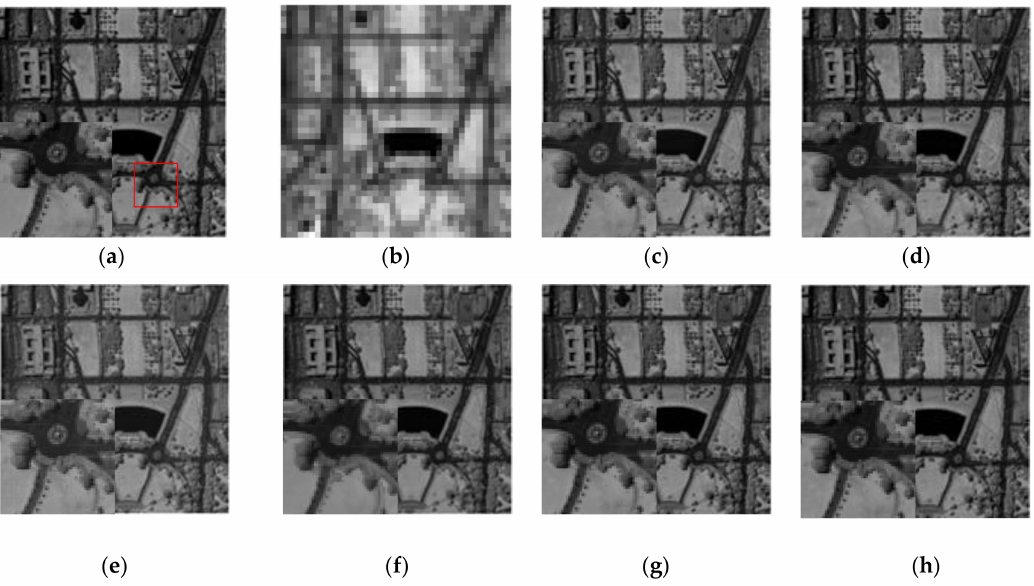
Figure 11. Details of original and resolution enhanced Washington D.C. HSS images at wavelength of 1204 nm: ( a ) reference; ( b ) input; ( c ) MAP; ( d ) CNMF; ( e ) Bayesian; ( f ) NSSR; ( g ) LASUF; ( h ) LASUF-OM.